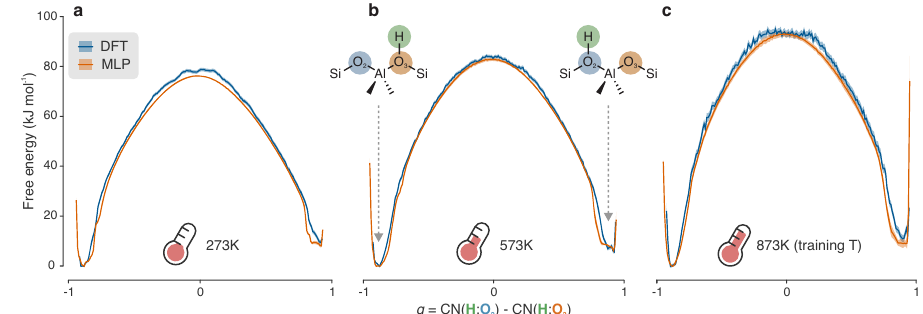
Fig. 3 | The trained MLP can reproduce DFT FESs with high accuracy. The MLP and DFT FESs (in orange and blue, respectively) of the 2 – 3 hopping at 273 ( a ), 573 ( b )and873K( c )arealmostperfectlysuperimposable,eventhoughtheMLPmodel is only trained on snapshots at the highest temperature. A comparison with the other available FESs is shown in Supplementary Fig. 10. For a more detailed de fi - nition of the collective variable ( q ) used to build the FESs, the interested reader